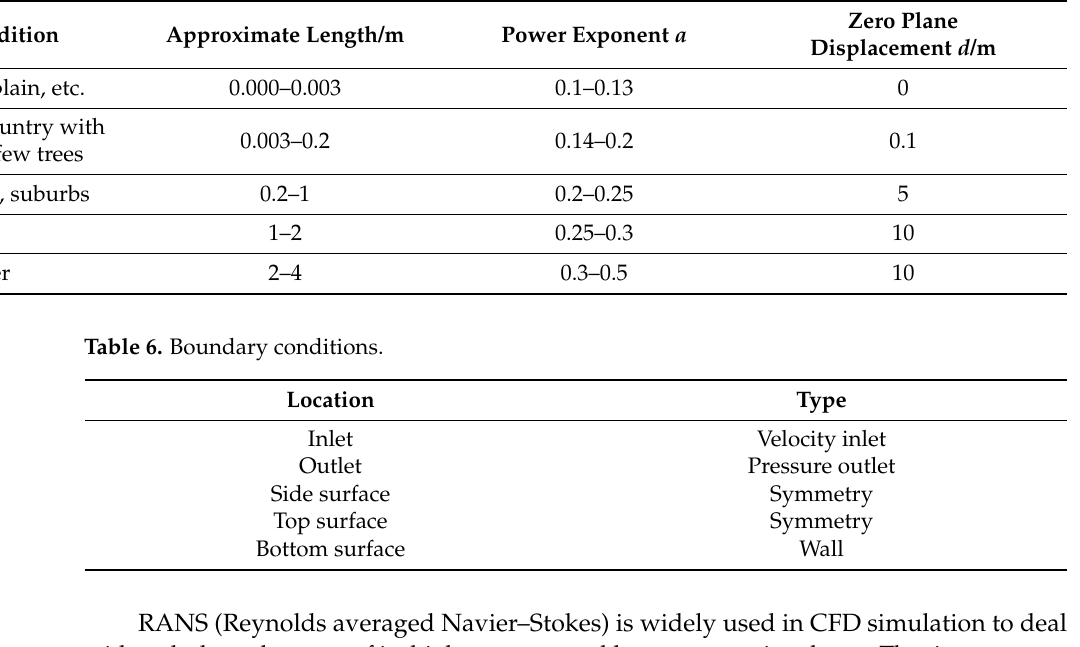
Table 5. Parameters of the mean wind speed profile.